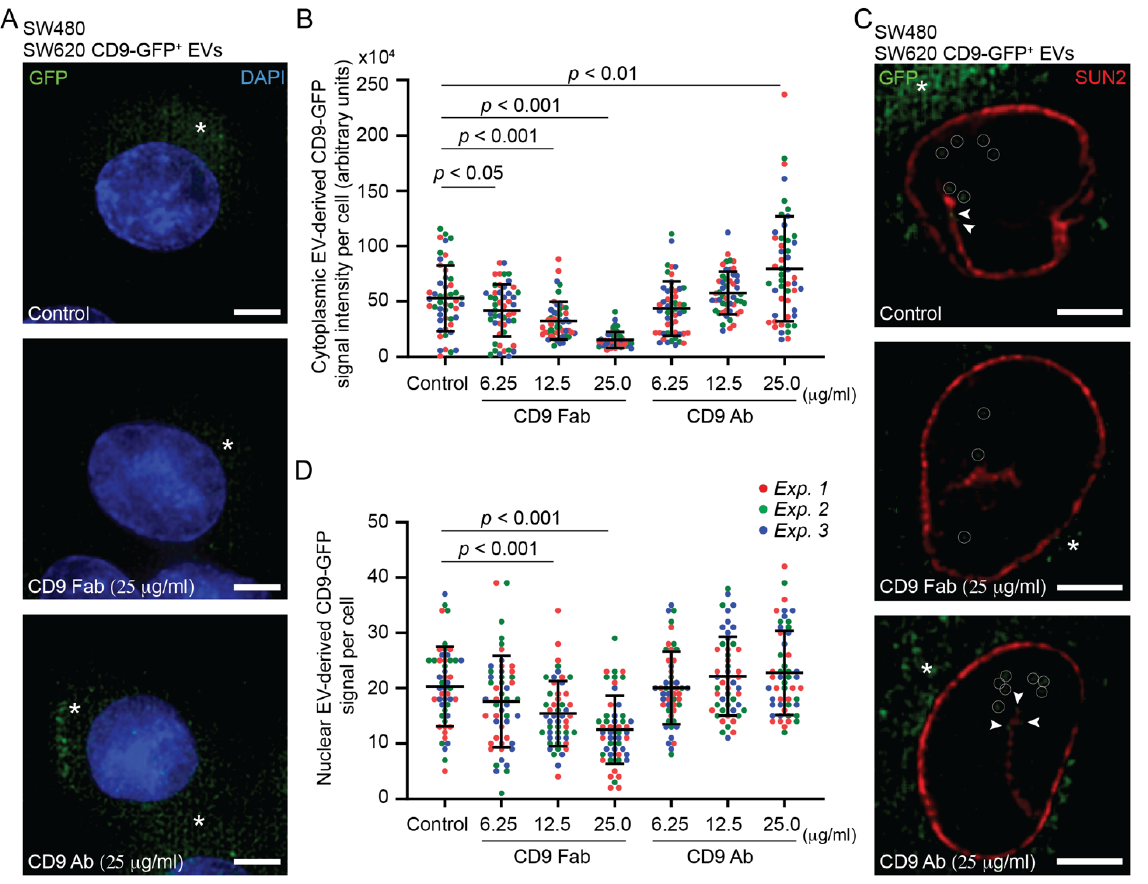
Figure 3. Effects of CD9 Fab and divalent Abs on the internalization of SW620 cell-derived CD9-GFP + EVs into SW480 cells. ( A – D ) SW480 cells and fluorescent EVs derived from CD9-GFP + SW620 cells (1 × 10 9 particles) were individually pre-incubated for 30 min without (control) or with different concentrations of anti-CD9 Fab or divalent Ab as indicated before their co-incubation for 5 h in the absence or presence of Abs (protocol #1). Fixed cells were either stained with DAPI ( A , B ) or immunolabeled for SUN2 ( C , D ) before observation by CLSM. Note the presence of discrete punctate GFP signals in the cytoplasmic ( A , C ) or nucleoplasmic ( C ) compartments (asterisk and circle, respectively). Their intensity ( B ) or amount ( D ) was quantified using serial optical sections through a cell (see Supplementary Figure S3). Means ± S.D. of individual signals from three independent experiments, as indicated by color coding, are shown ( n > 15 cells per experiment). p values are indicated. Arrowheads indicate CD9-GFP signals in the nuclear envelope invagination ( C ). Scale bars, 5 µ